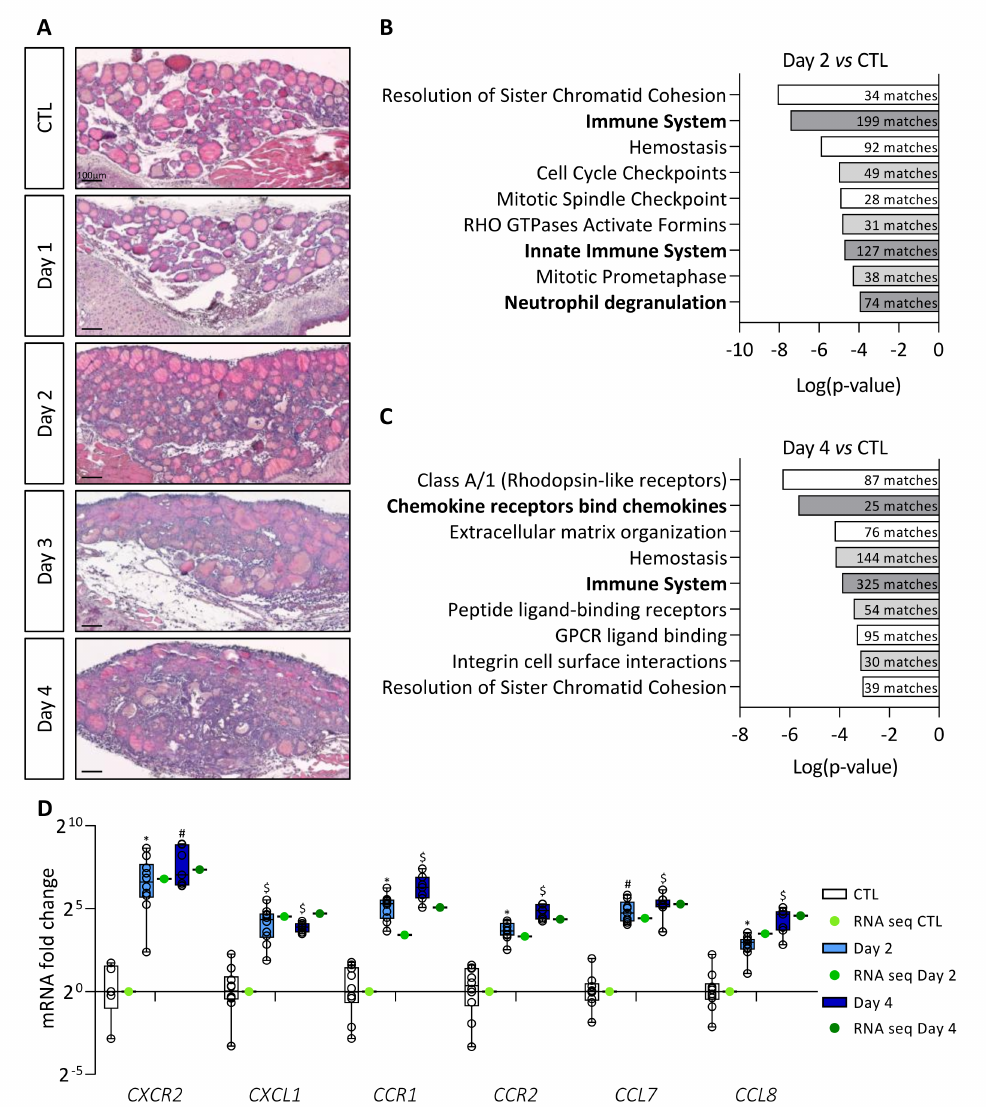
Figure 1. BRAF V600E induction in mouse thyrocytes triggers stromal reaction which correlates with major changes in immune signaling pathways. ( A ) Hematoxylin–eosin staining of thyroid tissue from control (CTL) and doxycycline-treated mice, from Day 1 to Day 4. ( B , C ) Enriched signaling pathway revealed by MouseMine software using differentially expressed genes from total RNA sequencing ( B ) of Day 2 ( n = 4) compared to CTL ( n = 4) thyroids and ( C ) of Day 4 ( n = 4) compared to CTL ( n = 4) thyroids. ( D ) mRNA fold change of the most deregulated chemokines ( CXCL1 , CCL7 , CCL8 ) and their receptors ( CXCR2 , CCR1 , CCR2 ) found in RNA sequencing data (green dots) and measured by RT-qPCR (white and blue boxes) of CTL ( n ≥ 5) and doxycycline-treated mice, after 2 ( n = 11) and 4 days ( n = 7) of injections (Day 2, Day 4). mRNA fold changes are normalized to the geometric mean of Rpl27 and Gapdh expression and compared to control group. Data are expressed as the mean ± SD (* p < 0.05, # p < 0.01, $ p <